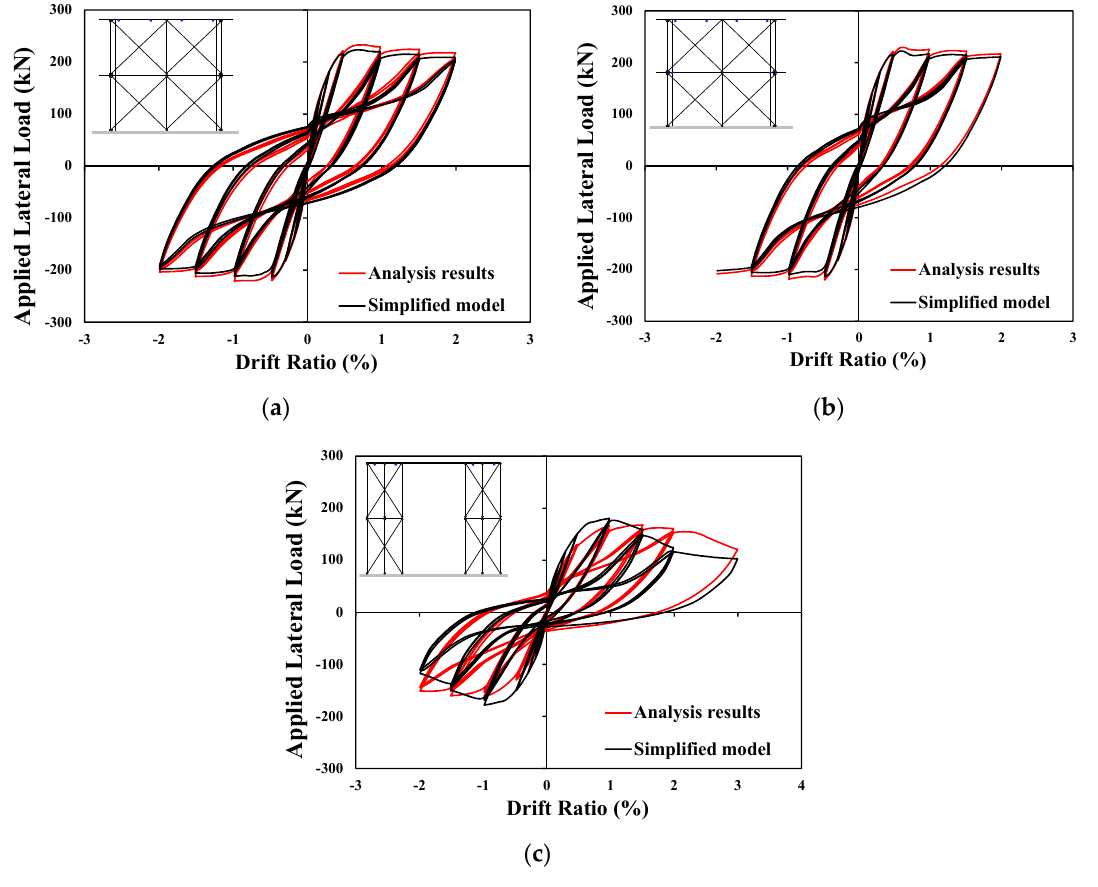
Figure 23. Load–displacement responses of idealized and simplified model: ( a ) Specimen FB; ( b ) Specimen FBC; ( c ) Specimen FPB.